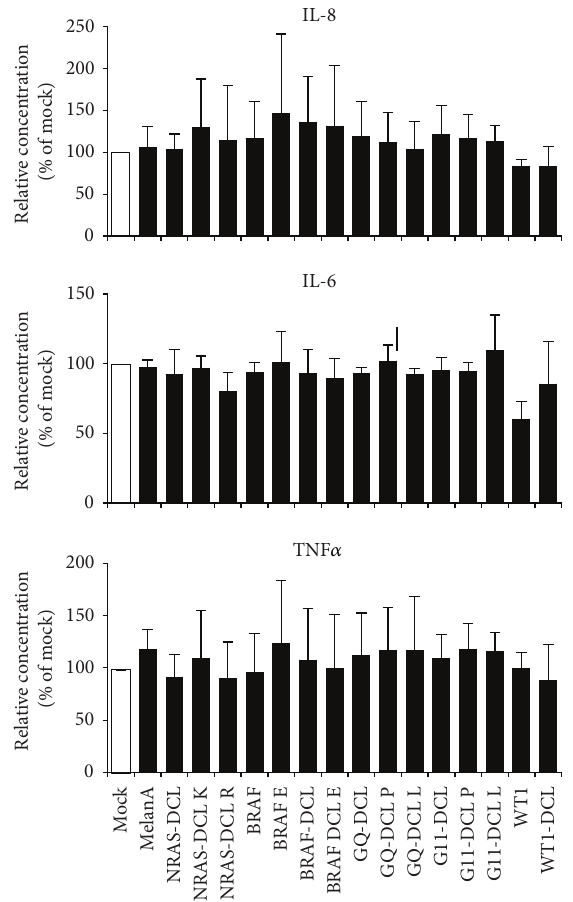
Figure 3: No difference in cytokine secretion between mock- and MelanA-RNA-electroporated DC. DCs were electroporated either without RNA (Mock) or with a panel of 16 RNAs encoding different tumor antigens, either mutated or not, and either linked to the lysosomal targeting signal DC-LAMP or not (see Table 1). Twenty- four hours after electroporation, supernatants of the cells were taken and the cytokine secretion by the cells was determined in a cytometric bead array. Cytokine secretion of mock-electroporated DCswasdefinedas100%andconcentrationsafterelectroporationof themRNAswereputinrelationtothat.Shownareaveragesofatleast 3 independent experiments. Error bars indicate the standard devia- tion (SD). According to a 1-way ANOVA with multiple comparison test, no statistically significant differences were present within the cytokine secretion data ( 𝑝 > 0.05